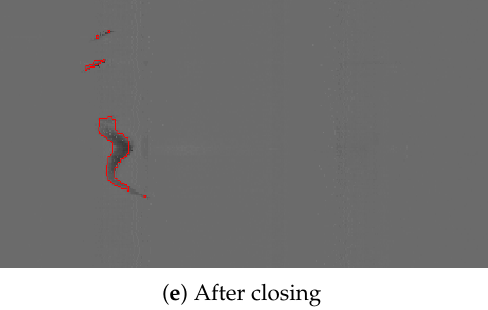
Figure 6. Segmentation